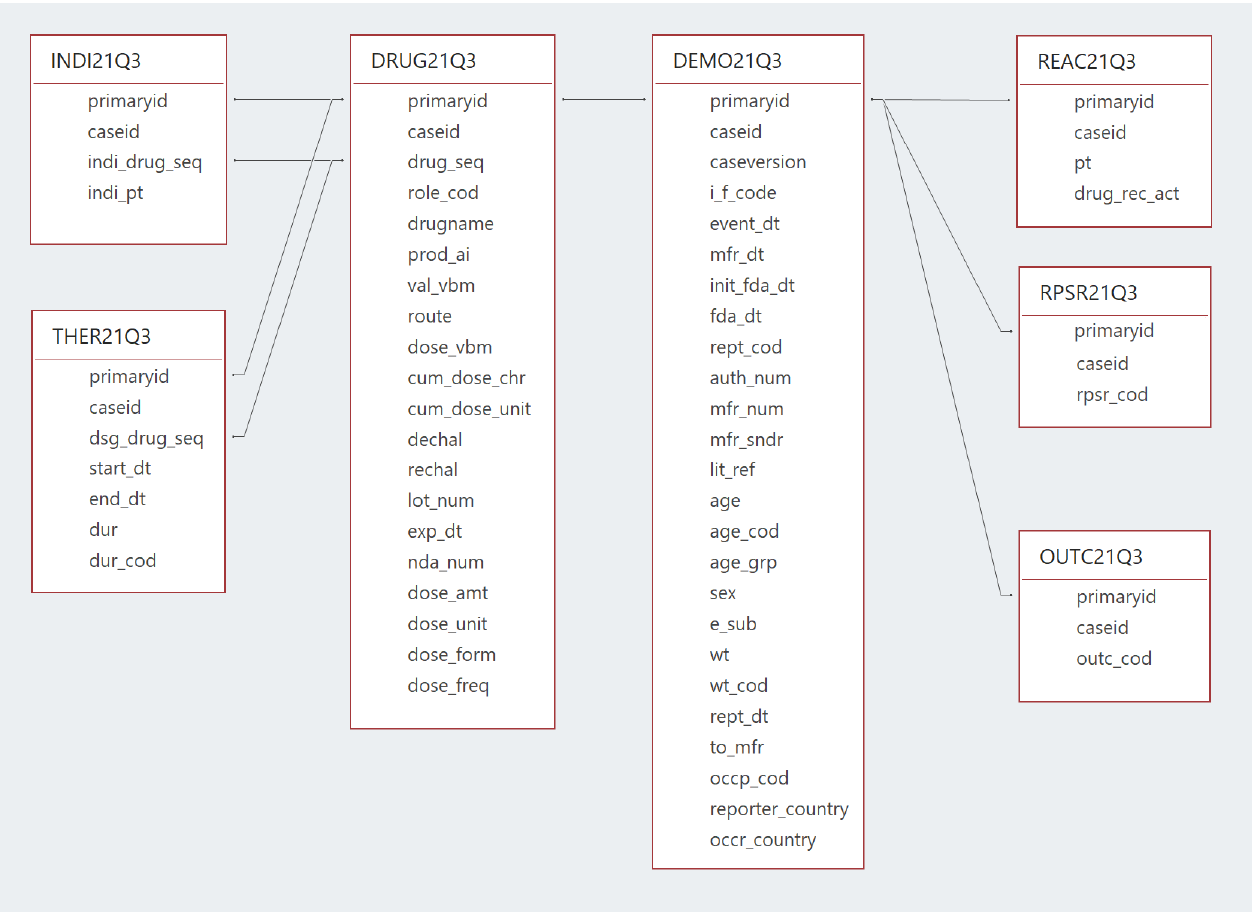
Figure 1. FAERS database structure and relationships.